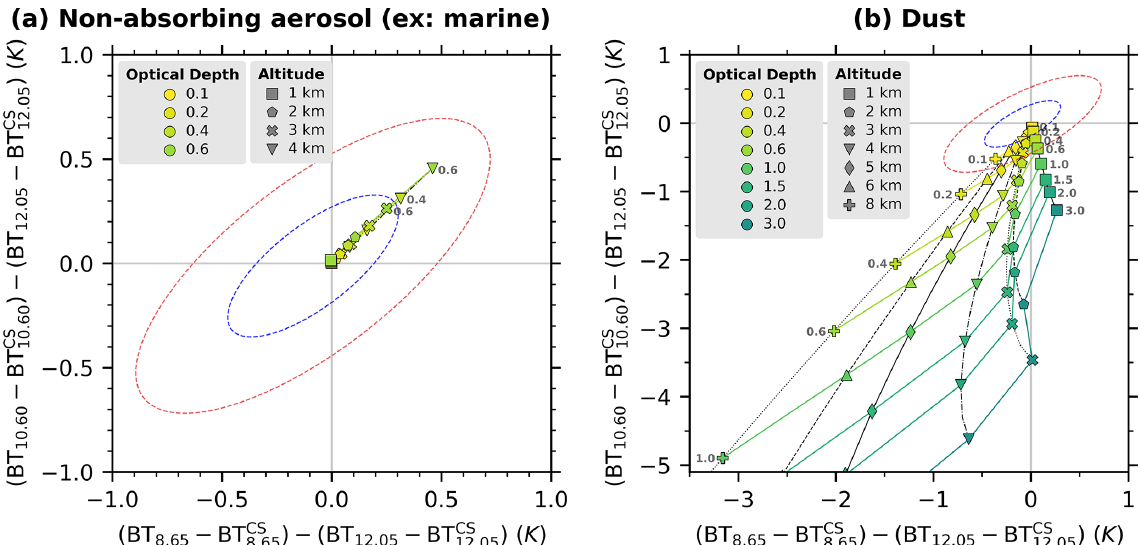
Figure 4. Radiative transfer simulations of the evolution of IIR signature (Sect. 3) with altitude and optical depth of (a) a non-absorbing aerosol layer and (b) an absorbing aerosol layer. Geometrical thickness of the layer is 1km. Optical properties of sea salt with relative humidity of 80% are used for the marine aerosol simulation. Optical properties of dust of Saharan desert in Mauritania are used for the dust simulation. The atmospheric profiles used for the simulations are those for a tropical atmosphere. The dashed red and blue ellipses represent the observed 95% and 50% confidence intervals of IIR clear-sky observations (see Fig. 2).